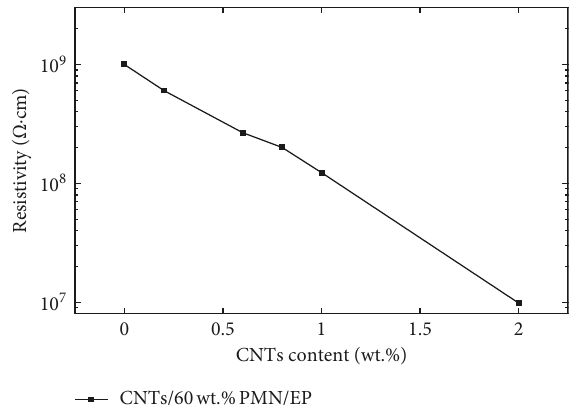
Figure 6: Resistivity of composites as a function of CNT